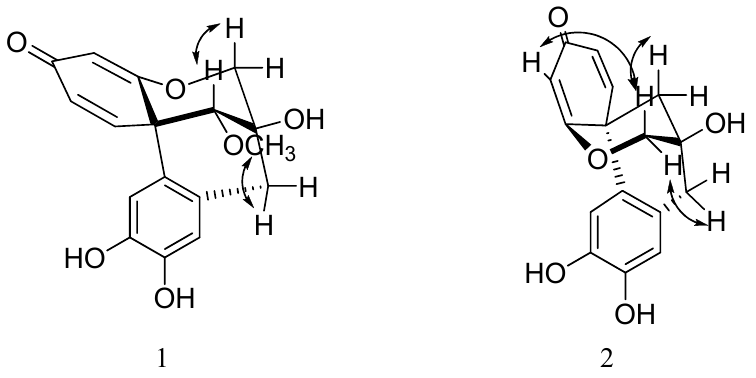
Figure 3. Key NOESY correlations of compounds 1 and 2